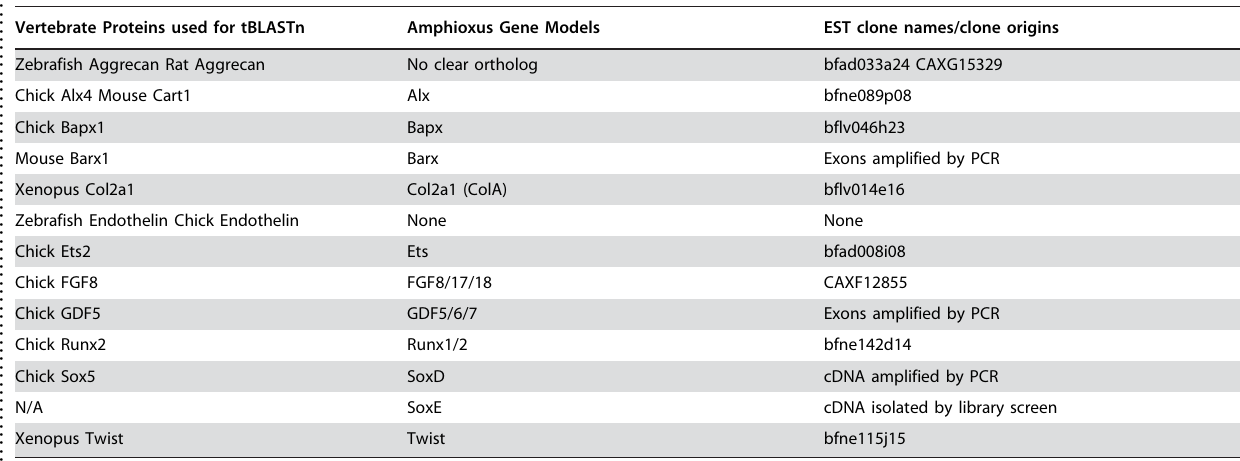
Table 1. The genes analyzed in this study and their corresponding cDNA clones. .. ... .... ... ... .... ... ... .... ... ... .... ... ... .... ... ... .... ... ... .... ... ... .... ... ... .... ... ... .... ... ... .... ... ... .... ... ... .... ... ... .... ... ...